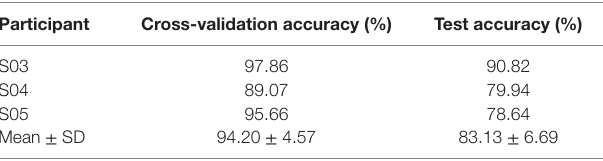
TaBle 5 | classification performance for participants with stroke (healthy hand).